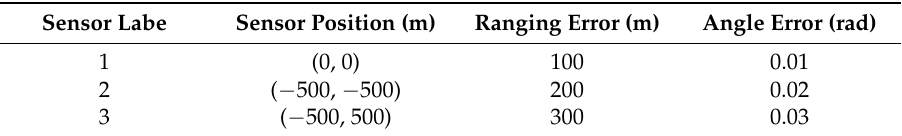
Table 2. Sensor position and parameter